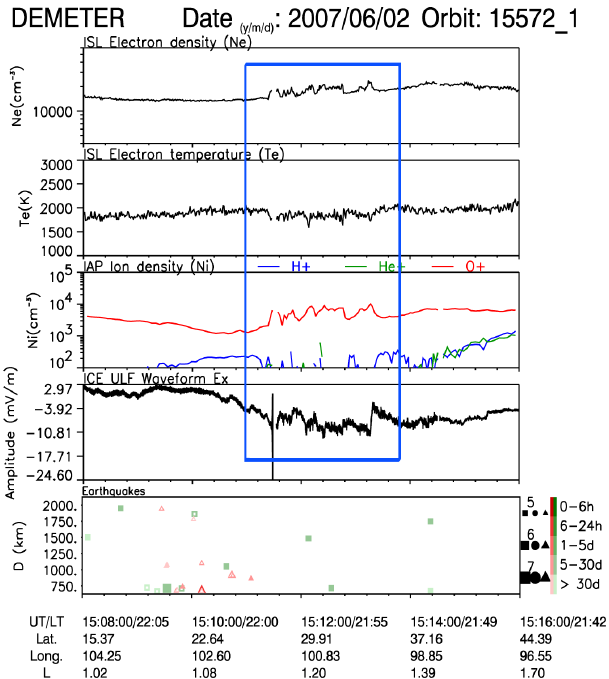
Figure 5. The observation of plasma parameters from DEMETER along orbit 15572 on 2 June before the Pu’er M6.3 earthquake in China on 3 June 2007 (the order of the five panels is the same as in Fig. 3).